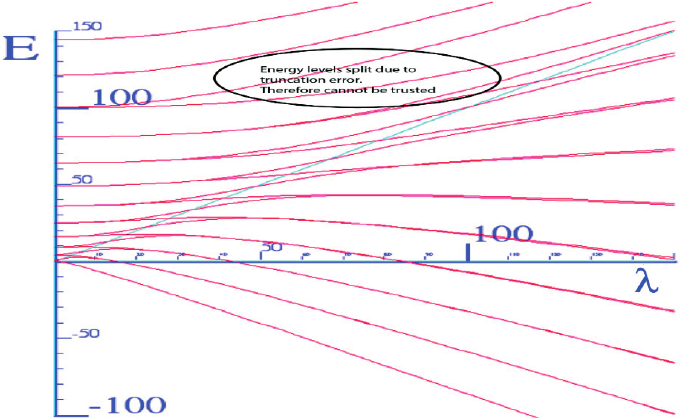
Figure 5. Energy vs. coupling for the Mathieu (truncation errors above E = 100 cm − 1 ).